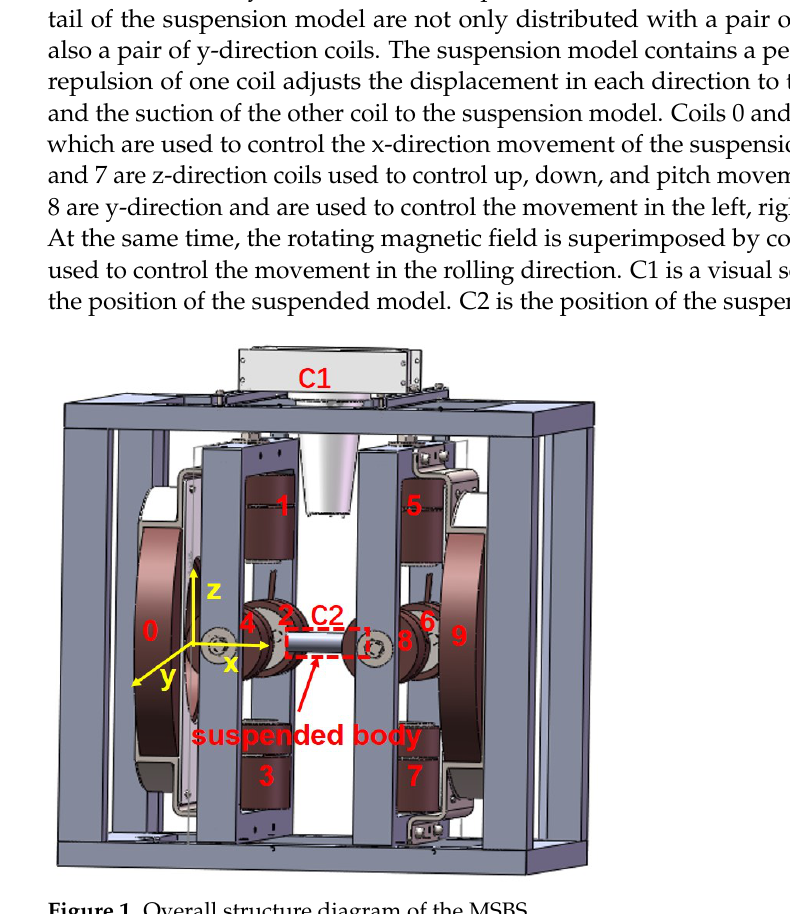
Figure 1. Overall structure diagram of the